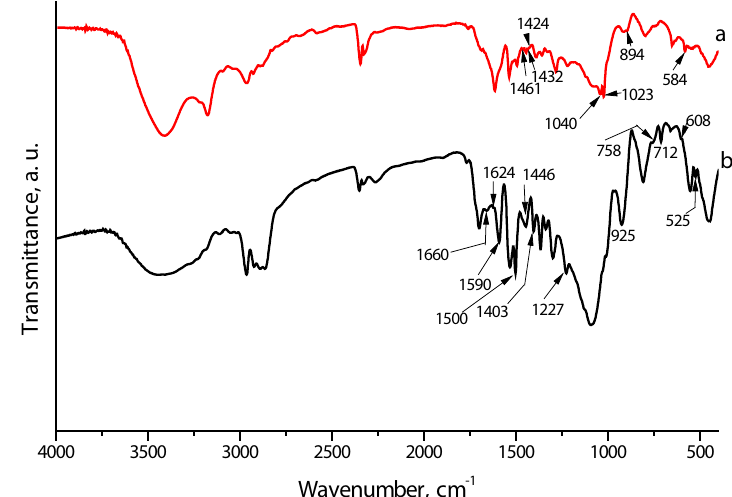
Figure 7. FTIR of the PU/10BG (a) and PU/20BG (b) after in vitro test in 1.5 SBF for 7